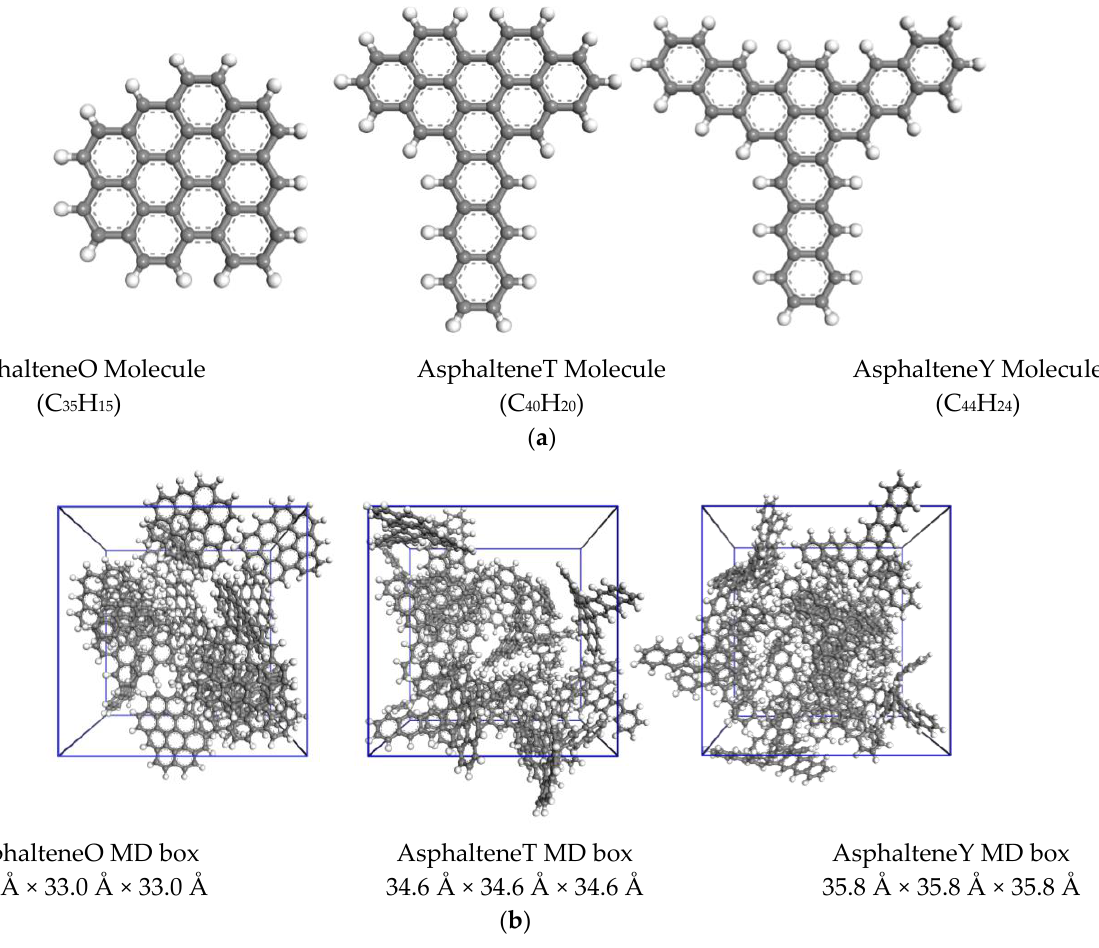
Figure 1. The molecular structure of the asphaltene molecules. Color coding of various elements: white, H; gray, C. ( a ) Molecular structures; ( b ) molecular dynamics modeling box.